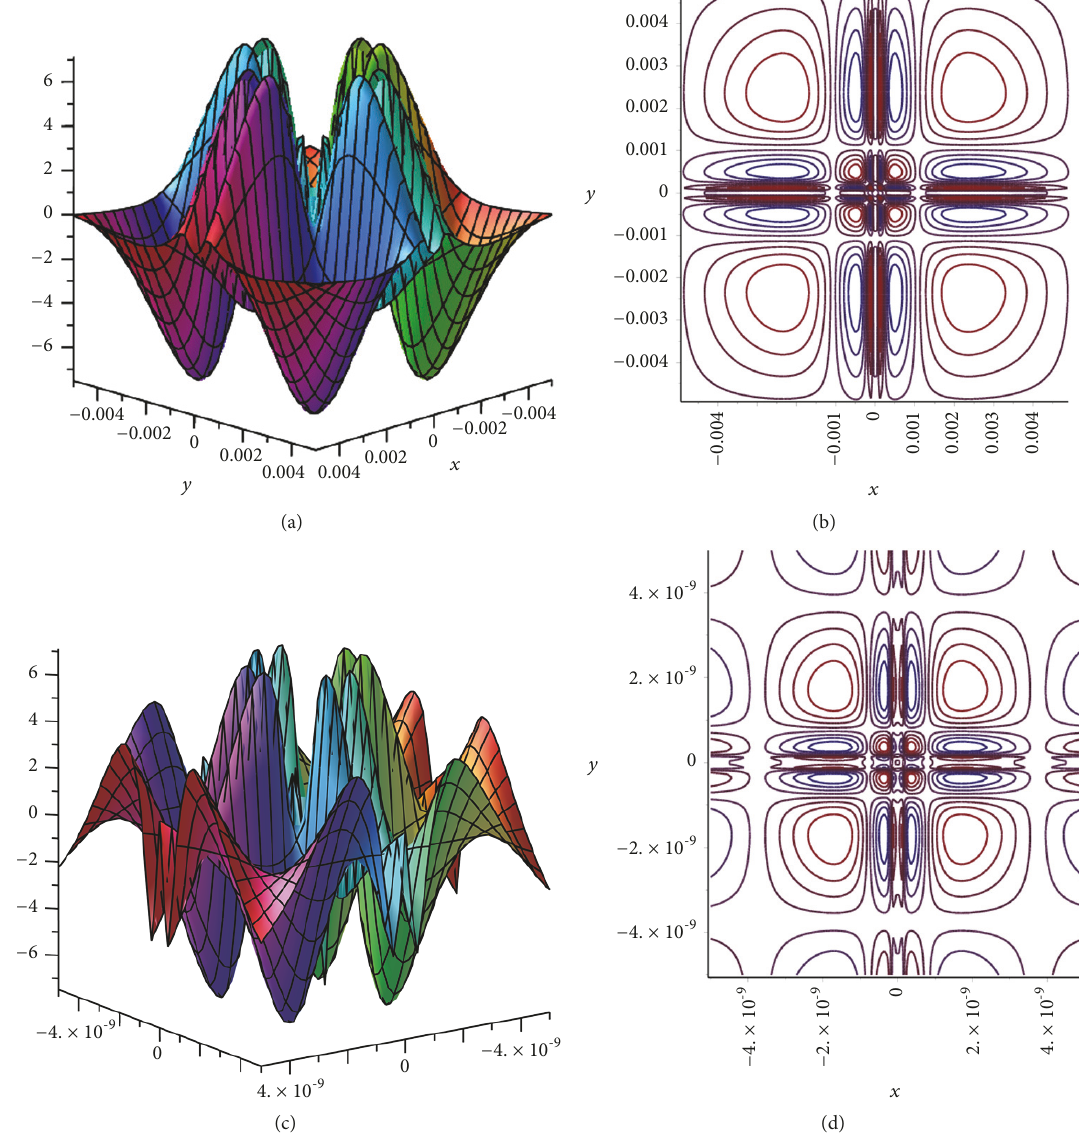
Figure 2: (a) Three-dimensional map, 𝑥,𝑦 ∈ (−5 ×10 −3 ,5 × 10 −3 ) . (b) Contour map 𝑥, 𝑦 ∈ (−5× 10 −3 ,5 ×10 −3 ) . (c) Three-dimensional map, 𝑥,𝑦 ∈ (−5 × 10 −9 , 5 × 10 −9 ) . (d) Contour map, 𝑥, 𝑦 ∈ (−5 × 10 −9 , 5 × 10 −9 )